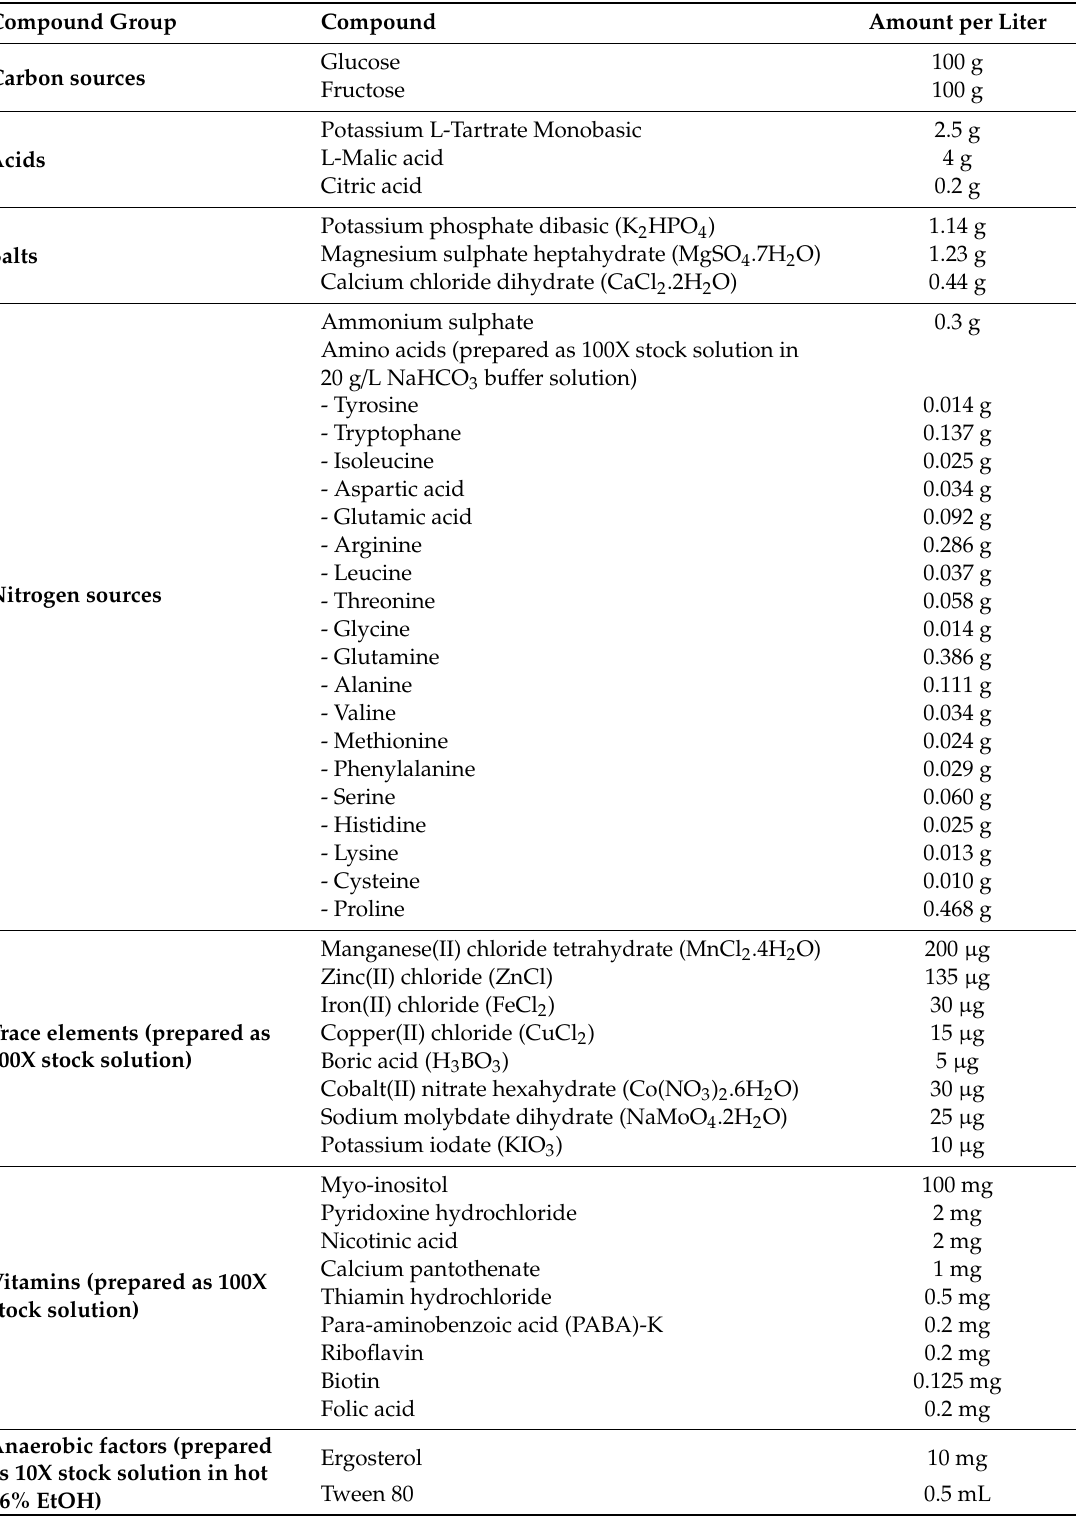
Table 1. Chemical composition of the synthetic medium (SM), simulating standard grape juice, adjusted from previous descriptions